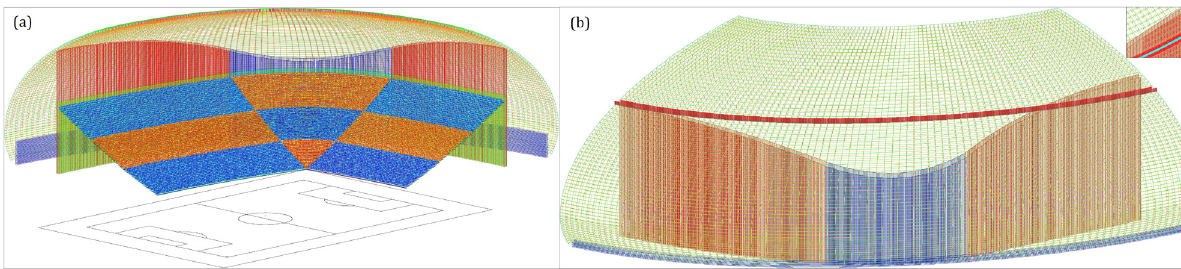
Figure 1: ( a ) Three - tier stadium with covered stands and ( b ) the ellipsoid - shaped elevation of the stadium with a footbridge.